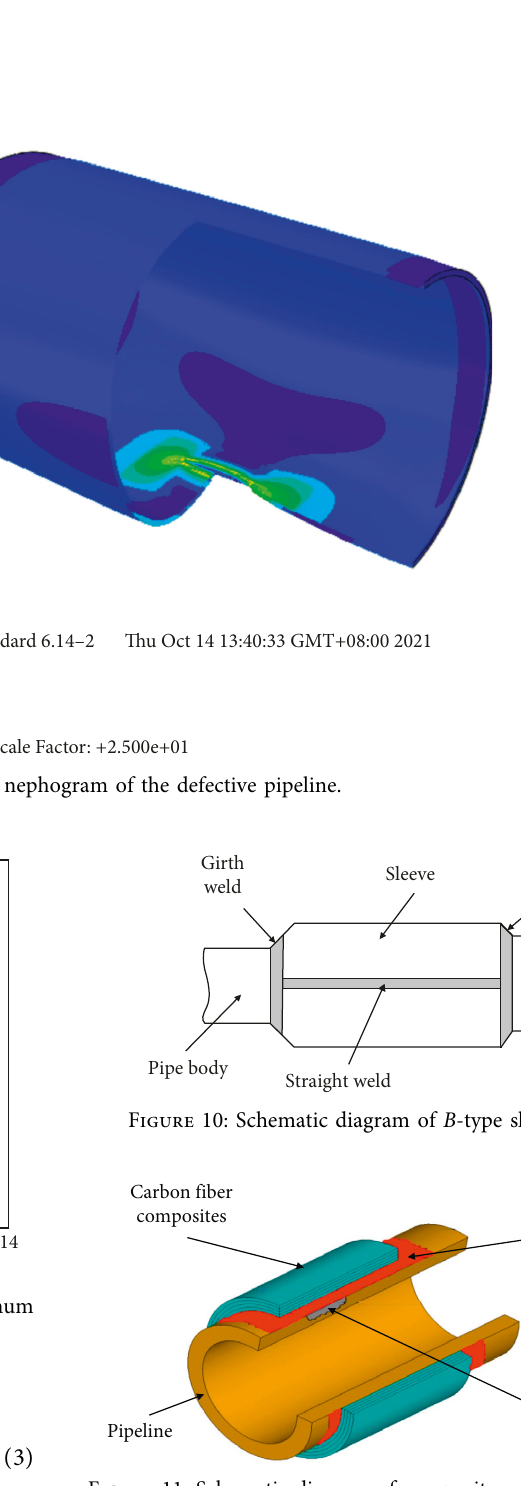
Figure 11: Schematic diagram of composite repair technology.